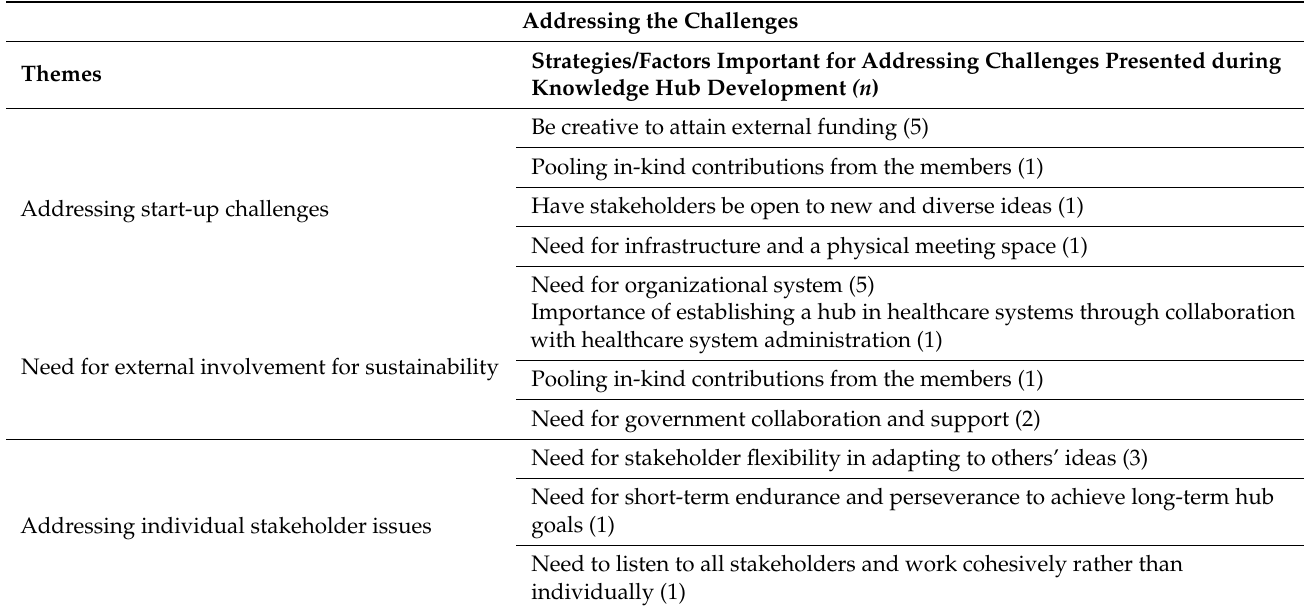
Table 6. Addressing the challenges of developing knowledge